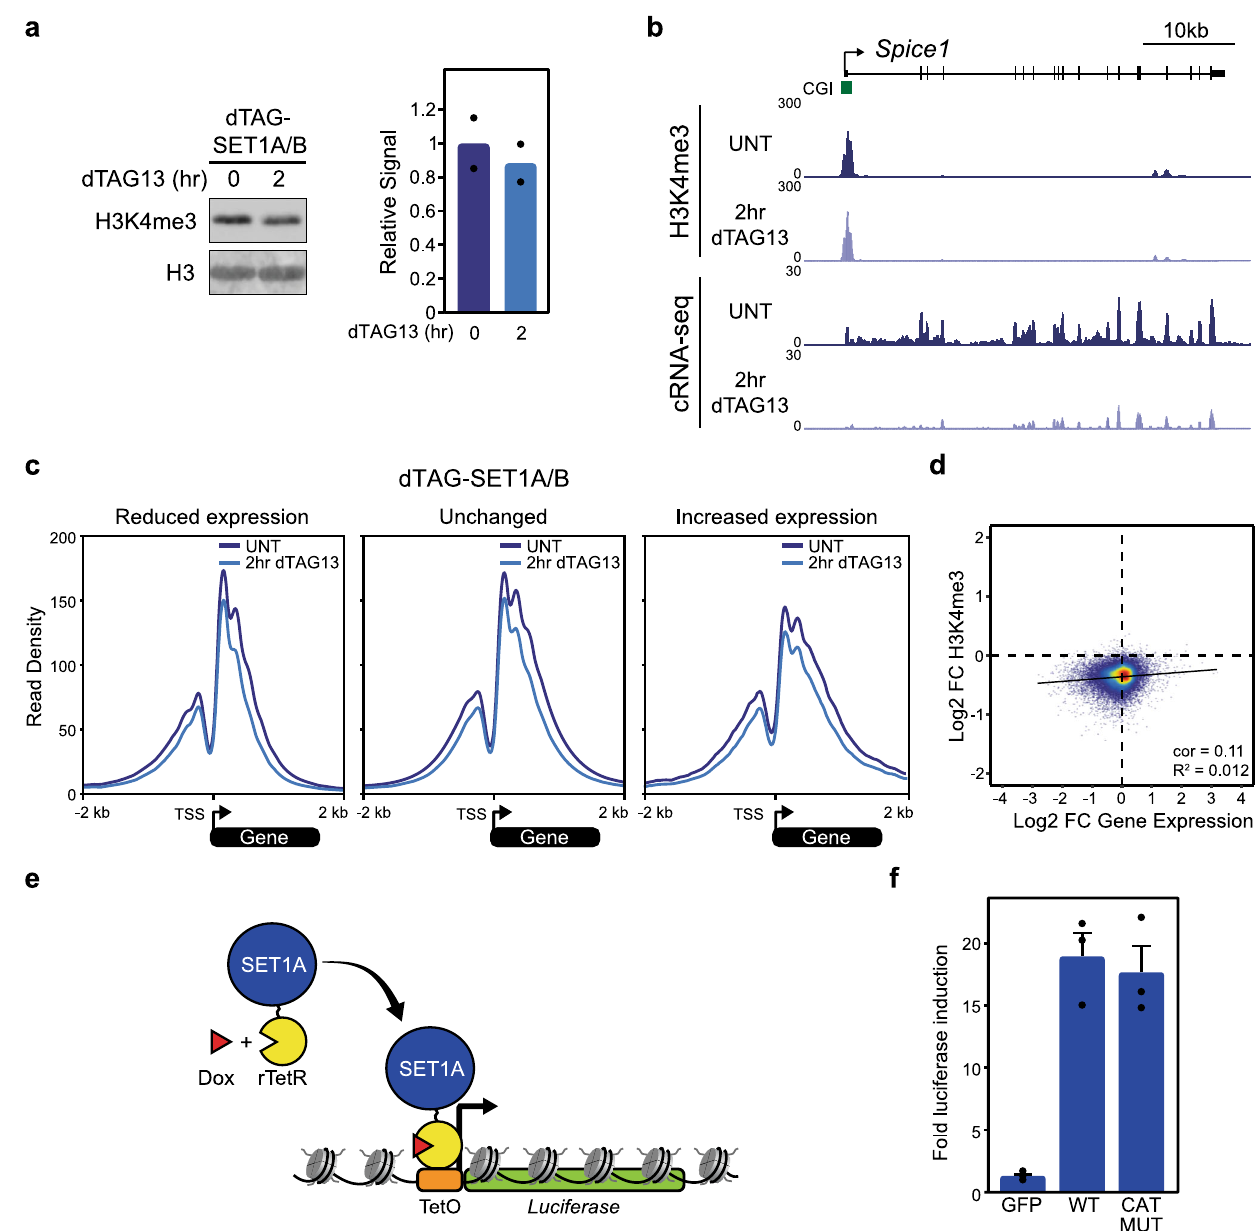
Fig. 2 | SET1 complexes can regulate gene expression independently of H3K4me3 and methyltransferase activity. a Western blot analysis of H3K4me3 levels in the untreated dTAG-SET1A/B line and following 2h of dTAG13 treatment (left panel). H3 is included as a loading control. Mean H3K4me3 levels before and after dTAG13 treatment from two biological replicates is shown (right panel). b A genomic snapshot comparing H3K4me3 cChIP-seq signal (top panels) and cRNA- seq signal (bottom panels) before and after 2h of dTAG13 treatment in the dTAG- SET1A/Bline at the Spice1 gene. c Metaplot analysis ofH3K4me3 cChIP-seqaround thetranscriptionstartsite(TSS)ofgenesthathavereducedexpression(leftpanel), unchanged expression (middle panel), or increased expression (right panel) in the dTAG-SET1A/Bline,before(UNT,darkbluelines)andafter2hofdTAG13treatment (lightbluelines).Onlyexpressedgenesareincluded(reducedexpression, n =2544;